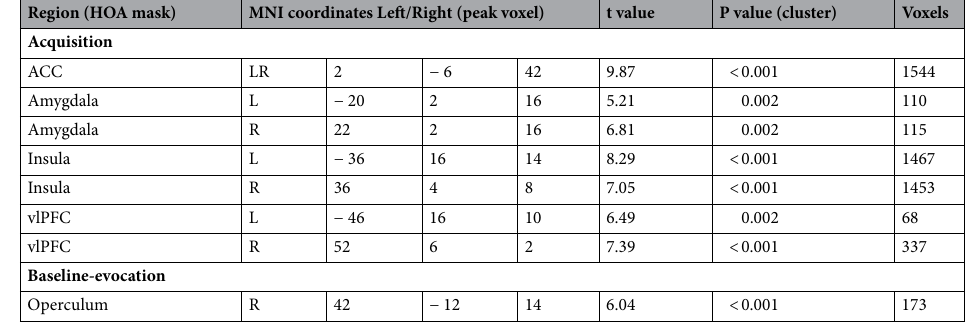
Table 2. Results of a priori ROI analyses for acquisition nocebo > control, and evocation nocebo > baseline high pain contrasts. Coordinates given in x, y, z for MNI space. T statistics calculated with df = 48, p < 0.05 FWE . HOA, Harvard Oxford Atlas; MNI, Montreal Neurological Institute; FWE, familywise error; vlPFC, ventrolateral prefrontal cortex; ACC, anterior cingulate